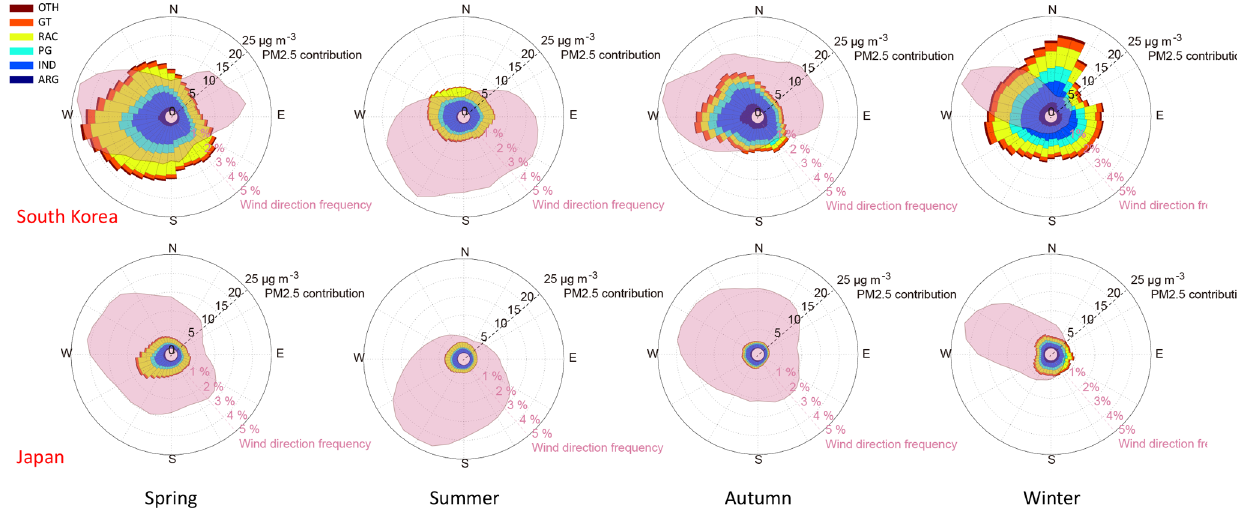
Figure 4. Seasonal wind roses for Japan and South Korea. Each direction bin presents the wind direction